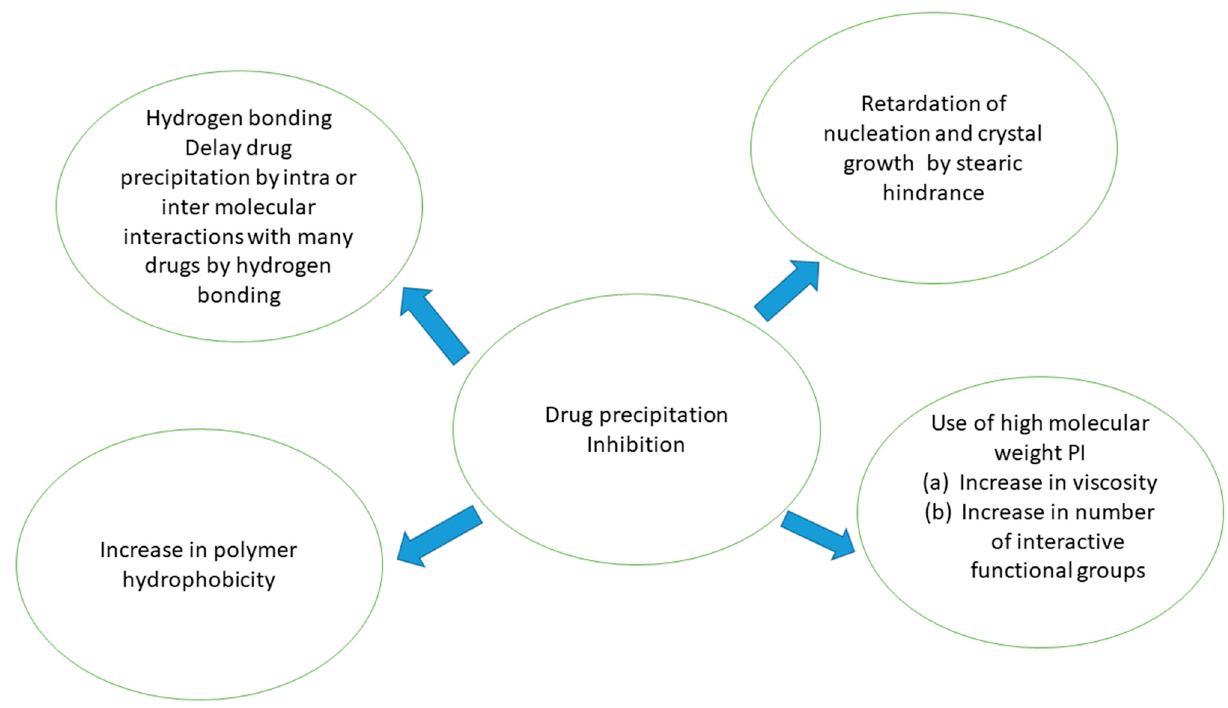
Figure 1. Mechanism of drug precipitation inhibition. Table 1. Supersaturated drug delivery systems and precipitation